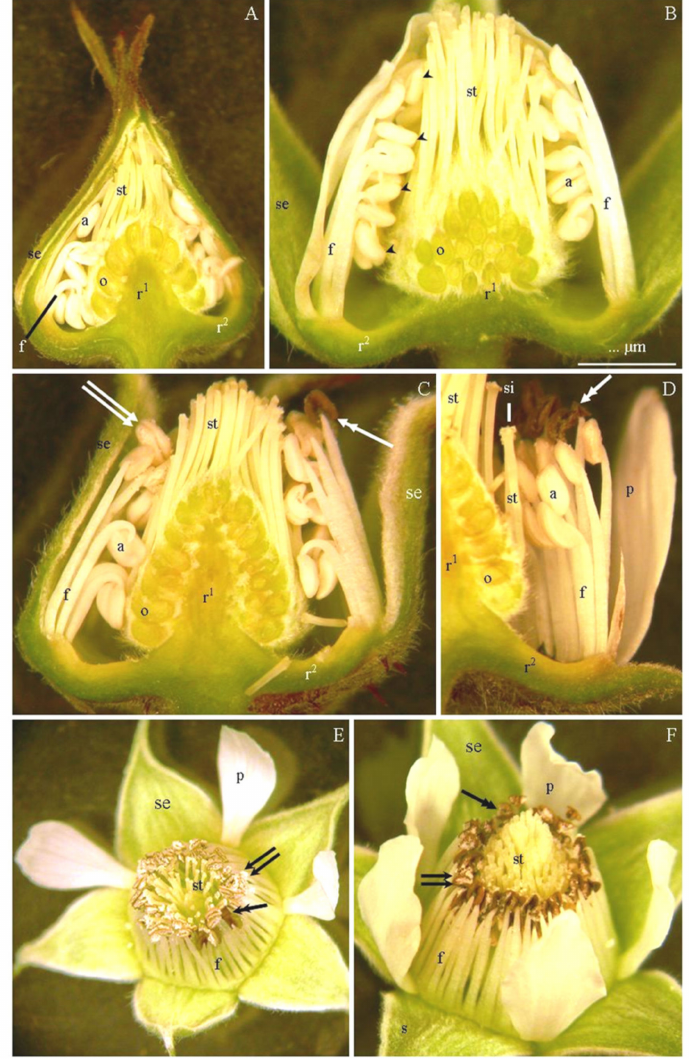
Figure 3. ( A – F ). Stamens and other floral elements at different stages of flower development ( A – D ): ‘Glen Ample’ ( A ), ‘Laszka’ ( B ), ‘Radziejowa’ ( C ), ‘Polka’ ( D ), ‘Polana’ ( E ), and ‘Pokusa’ ( F ): ( A )—tightly arranged stamens at the closed-bud stage with folded filaments (f) and closed anthers (a) arranged around the ovary (o); long pistil styles (st), sepals (se), convex (r 1 ) and con- cave (r 2 ) receptacle, ( B )—white opening bud, closed stamen anthers (a), straightened filaments (f) located along the margin of the concave receptacle (r 2 ), numerous ovaries (o) with long styles (st) on the convex receptacle (r 1 ), ( C , D )—onset of pollen release (double-headed arrow) at the initial flowering stage of the flower; stamens with filaments (f) straightened in the outer whorl and folded in the inner whorl and with closed anthers ( a ) in the pollen release phase (two arrows) or in the post-pollen release phase (double-headed arrow), sepals (se), convex (r 1 ) and concave (r 2 ) receptacle, ( E , F )—dehiscent anthers (two arrows) in the flower at the initial flowering stage ( E ) and after pollen release (double-headed arrow) at the full bloom stage ( F ), straightened filaments (f) surrounding the pistil style (st), corolla petals (p), and sepals